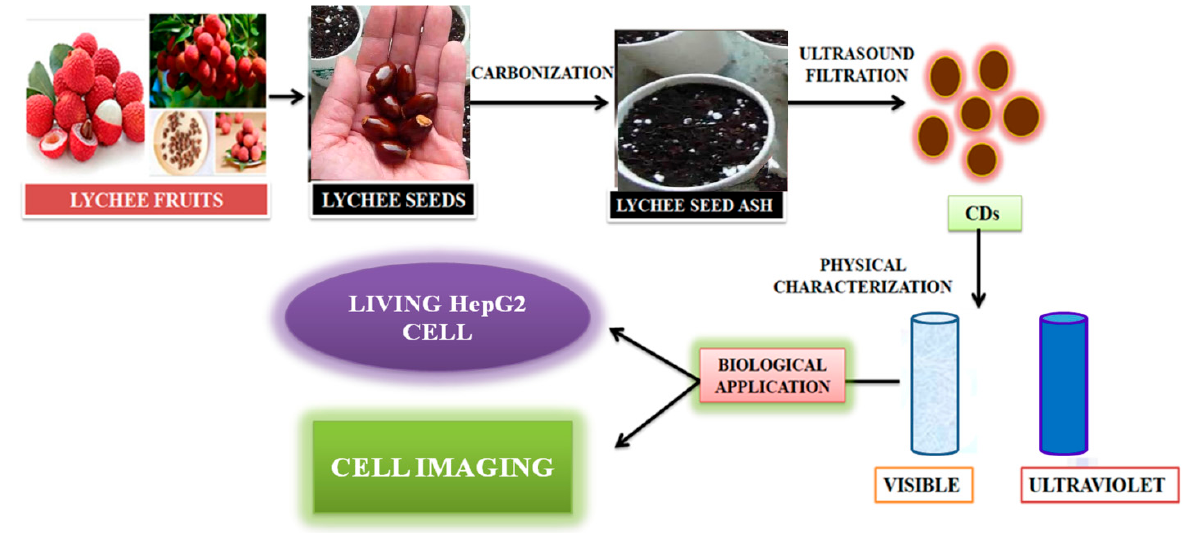
Figure 7. Synthesis of carbon dots from lychee seeds. The CDS were used for fluorescence imaging of living HepG2 cells, as described in [106].